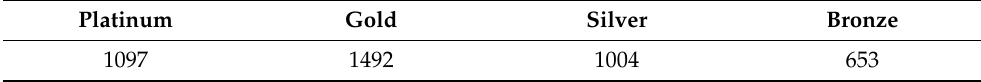
Table 3. User Level